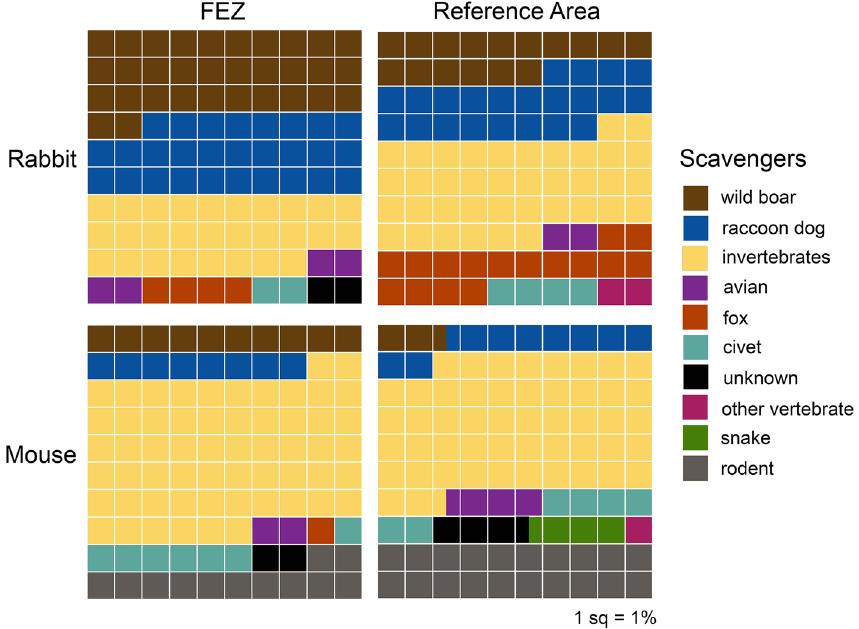
Figure 4. Experimentally placed mouse carcasses (n = 175) and rabbit carcasses (n = 100) removed by different scavenger species in both the Fukushima Exclusion Zone (FEZ) and inhabited reference area from May to July 2018. Scavengers were considered to have removed a carcass if they consumed or removed > 50% of the